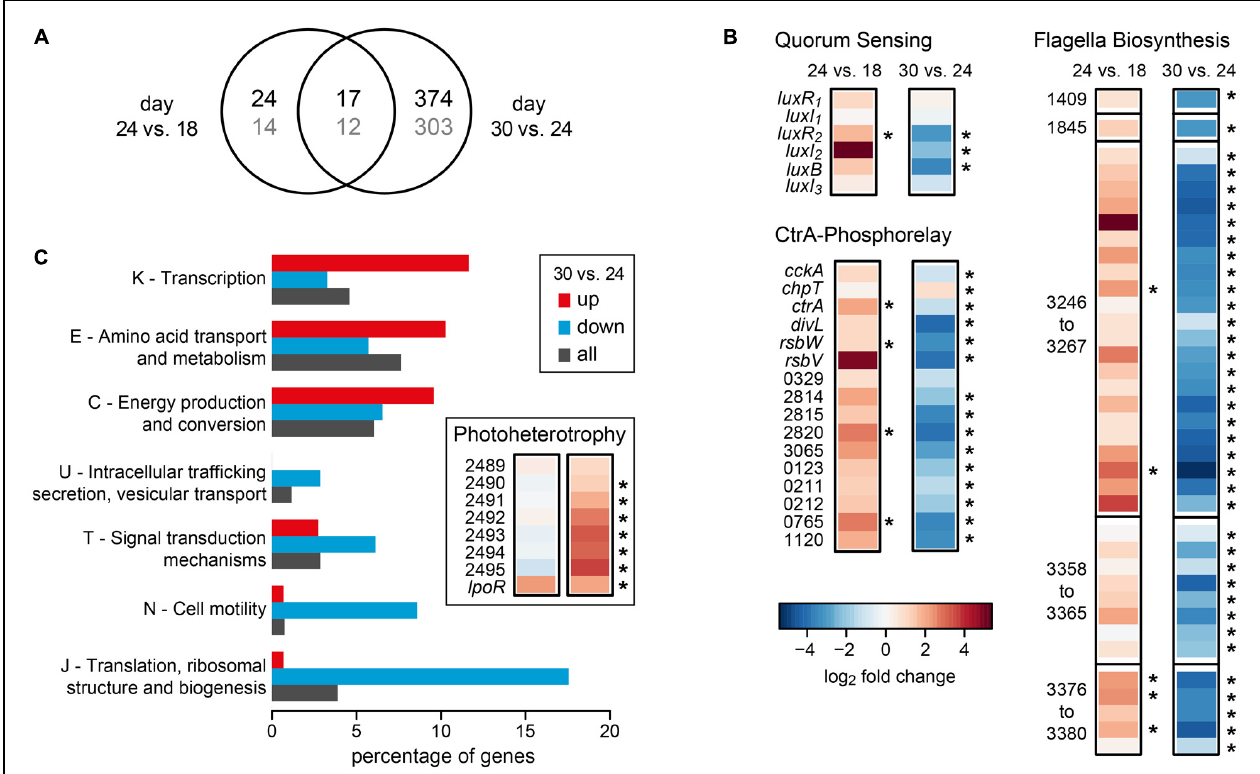
FIGURE 2 | Differential gene expression of D. shibae during the transition from mutualistic to pathogenic (day 24 vs. day 18) and from pathogenic to stationary phase (day 30 vs. day 24). (A) Venn-diagram showing the overlap in the number of differentially expressed genes for both comparisons. The number of genes with COG-annotation is shown in gray. (B) Differential expression of genes of the Quorum sensing system, the CtrA phosphorelay and flagella biosynthesis (two single genes and three gene clusters). Asterisks indicate significant differences in expression ( p -value < 0.05). Identifiers are either the gene symbols or the locus tags according to Supplementary Table S2. (C) Significantly enriched COG-categories ( p -value < 0.1) for the comparison of day 30 with day 24. The percentage of genes of enriched categories is shown for up- and down-regulated genes. The percentage of all genes in the genome of D. shibae that have been assigned to the respective category is shown for comparison. Inlay: differential expression of genes with relevance for aerobic anoxygenic photosynthesis.